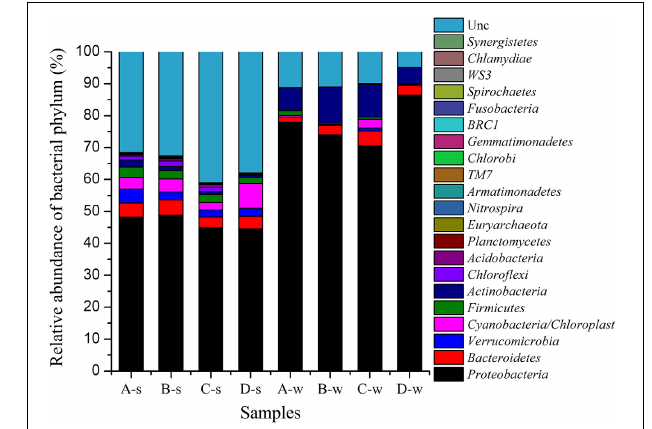
FIGURE 3 | Relative abundance of antibiotic resistance genes (ARGs) in all samples.